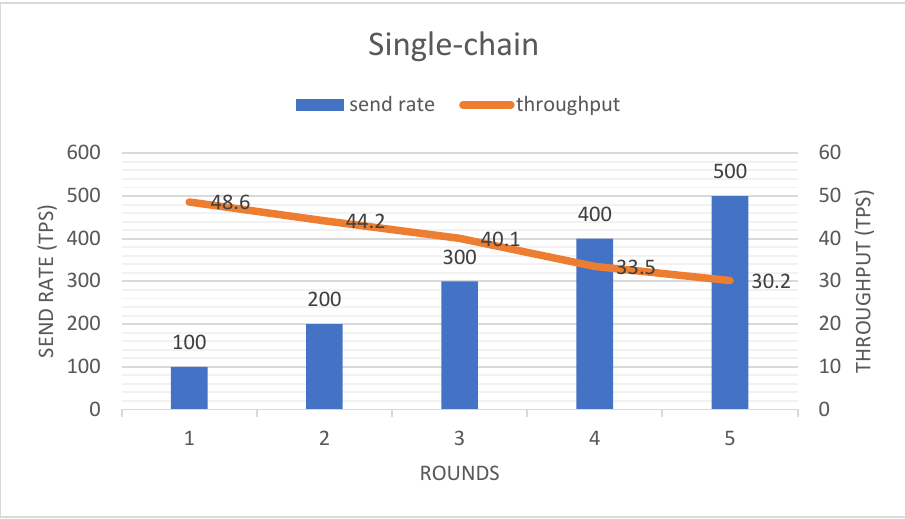
Figure 27. Transaction throughput evaluation of single-chain architecture.